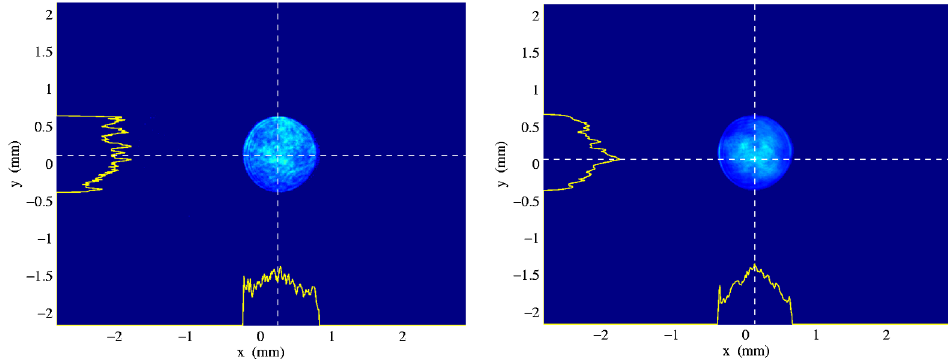
FIG. 5. Regular nearly uniform laser spatial profile (left) and truncated-Gaussian spatial profile at the cathode (right). Edge to edge laser size for both cases is 1 mm.